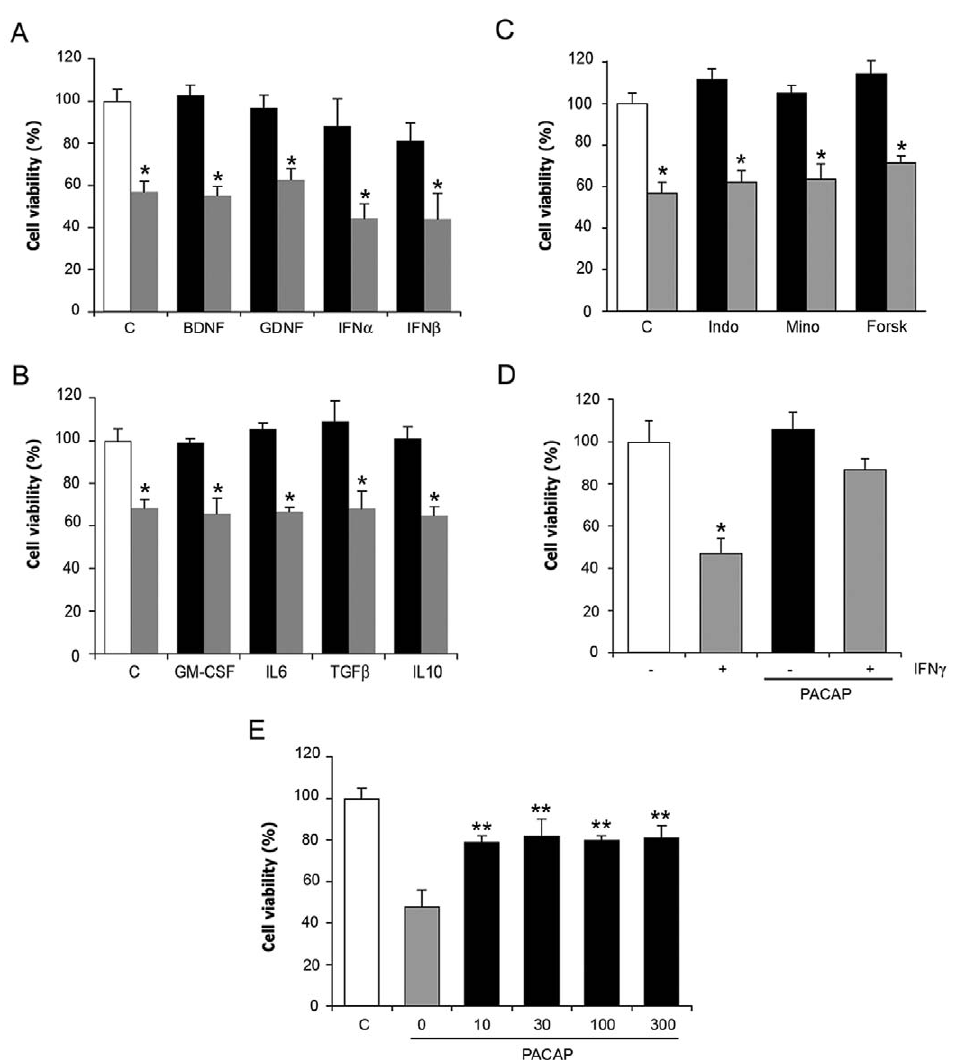
Figure 5. Effects of different factors in IFN c -treated NPCs. NPCs were untreated (white bars) or treated for 24 h with various factors alone (black bars) or together with 100 ng/ml IFN c (grey bars). Cell viability was assayed by MTT. Values are means 6 SD, n=4. *p , 0.05 for IFN c treated vs. controls. ( A ) BDNF and GDNF were used at 50 ng/ml and IFNs at 100 ng/ml. Values are means 6 SD, n=4. No increase in viability by the factors. ( B ) Different cytokines were used at 50 ng/ml. No increase in viability by the factors. ( C ) 100 ng/ml Indometacin (Indo), 100 ng/ml Minocyclin (Mino), and 1 m M Forskolin (Forsk) were used. No increase in viability by the compounds. ( D ) 100 ng/ml PACAP increased cell viability reduced by IFN c . ( E ) Dose response curve for PACAP. **P , 0.01 for PACAP + IFN c vs. IFN c